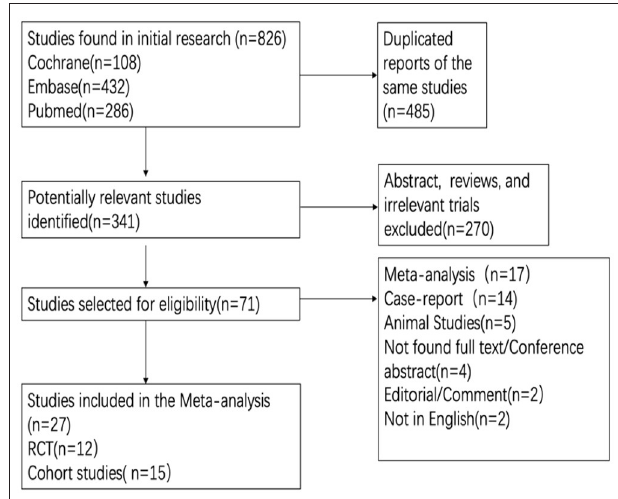
FIGURE 1 | Flowchart of the literature search and study